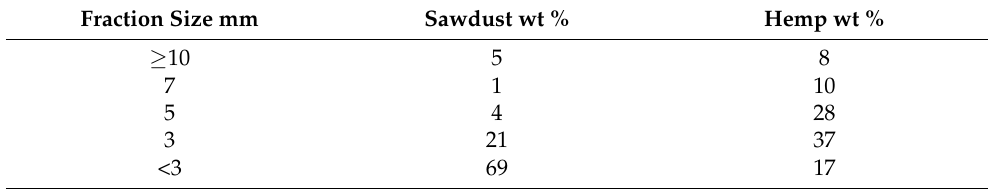
Table 1. The particle size and weight percentage of each fraction in the hemp and sawdust substrates. Fraction Size mm Sawdust wt % Hemp wt % ≥ 10 5 8 7 1 10 5 4 28 3 21 37 <3 69